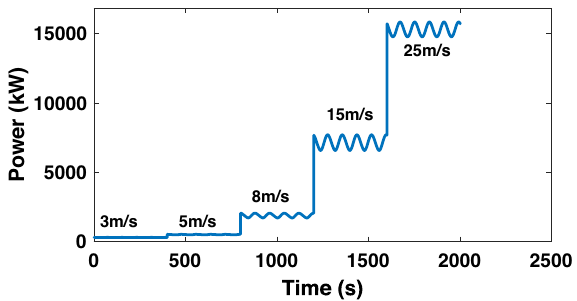
Figure 8. Full operating range response test for the uncontrolled model.